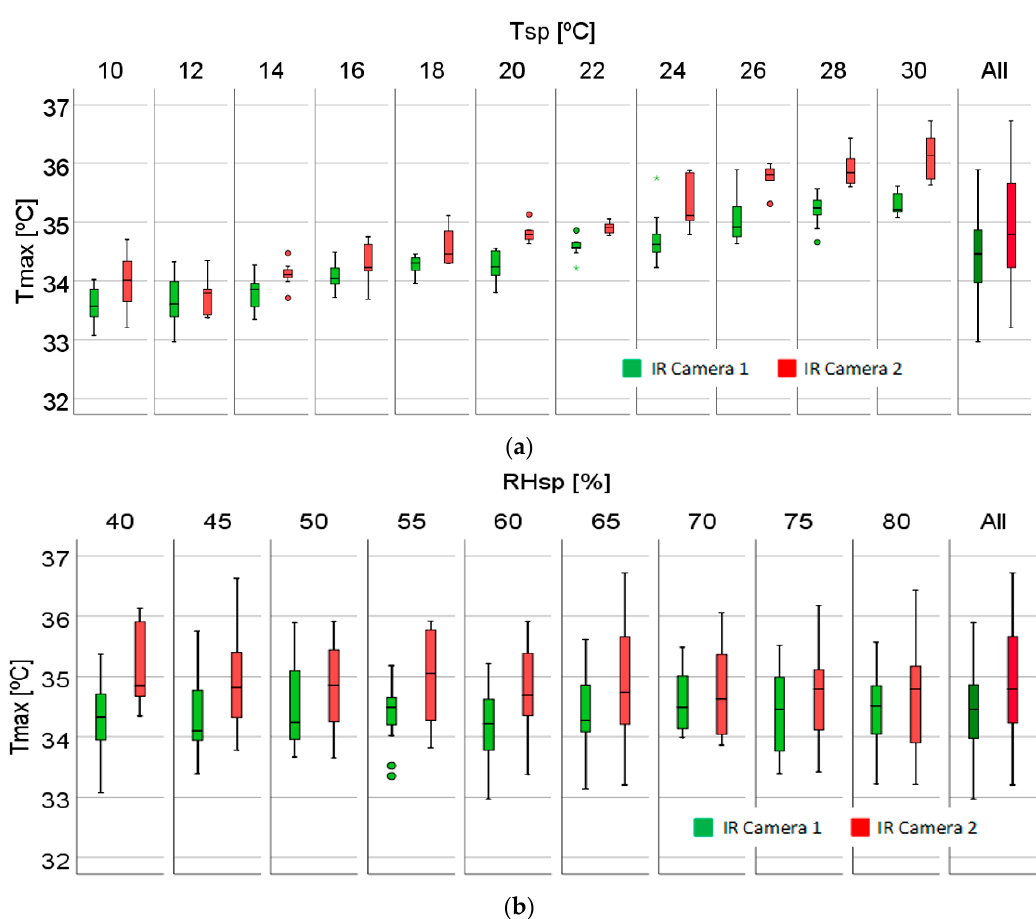
Figure 9. Box plot representations of the maximum temperatures for the entire range: ( a ) T SP ; ( b ) RH SP